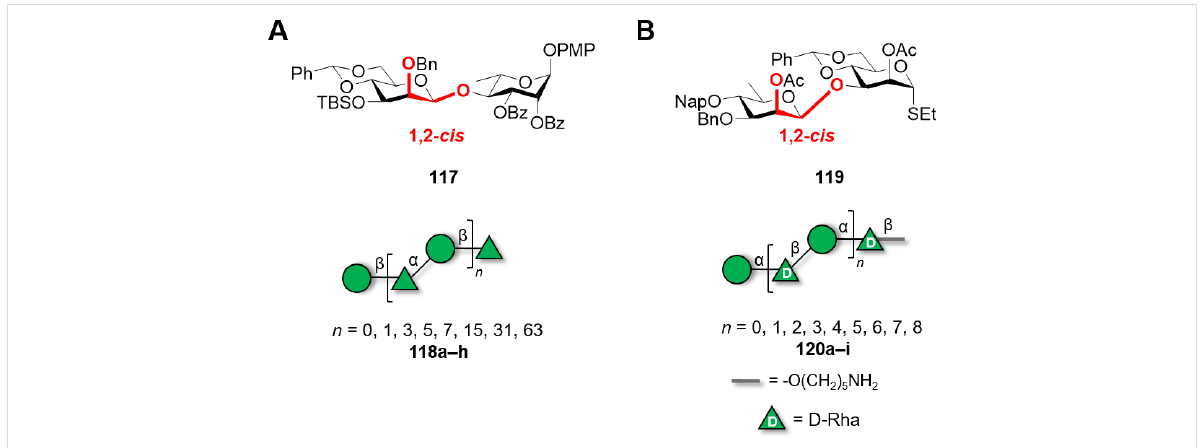
Figure 9: Key BBs for the synthesis of the O -antigen of Bacteroides vulgatus up to a 128mer (A) and the CPS of Clostridium bolteae up to 18mer (B). The most challenging 1,2- cis glycosidic linkage is installed in the key BBs and highly stereoselective 1,2- trans α -rhamnosylation or α -mannosylation were exploited for